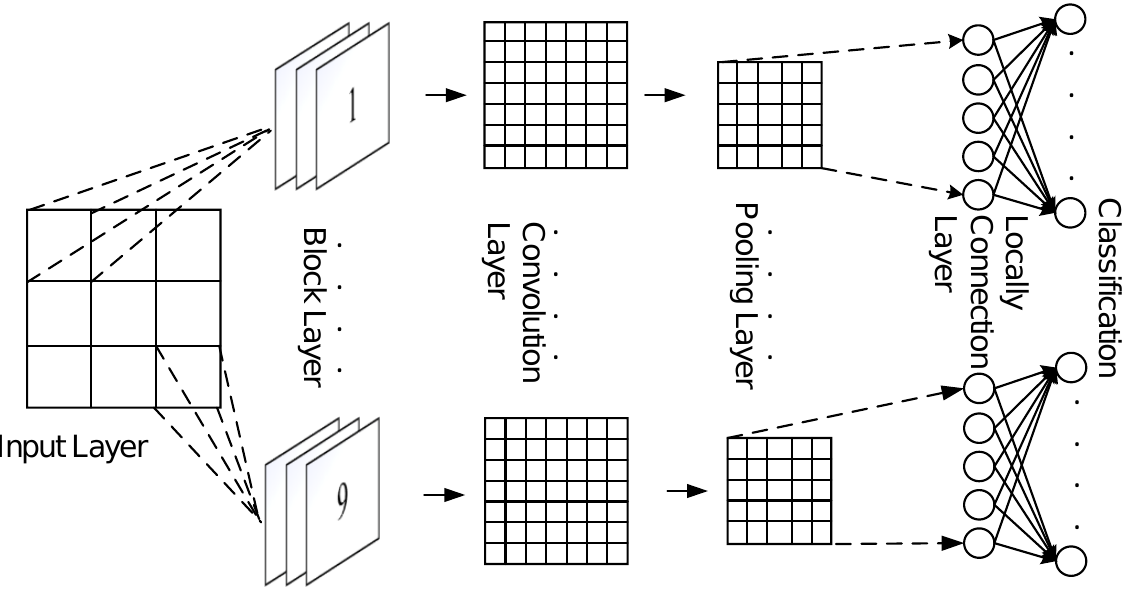
Figure 2. The structure of the multi-convolution neural network.